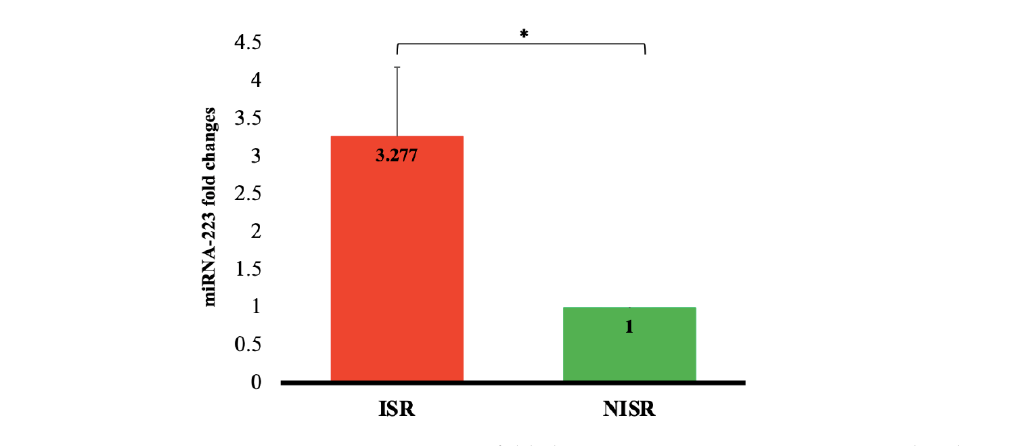
Figure 1. Serum miRNA-223 fold change expression in ISR patients related to NISR as a control group. Data are expressed as mean ± SE. * p < 0.05. Table 4. Binary logistic regression for miRNA-223 expression in relation with ISR (ref: NISR).